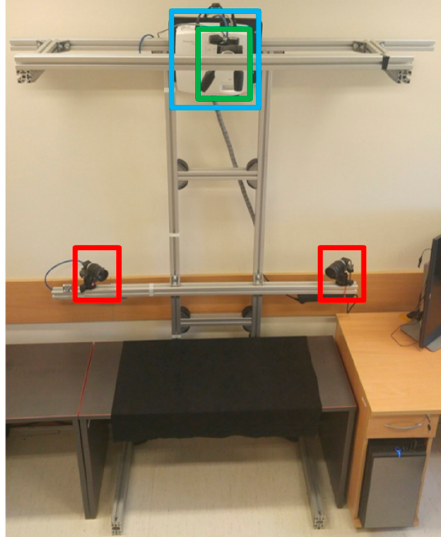
Figure 9. Prototype of MARVIS comprising the HdTM cameras (red), PrM projector (cyan), and PhTM camera (green).